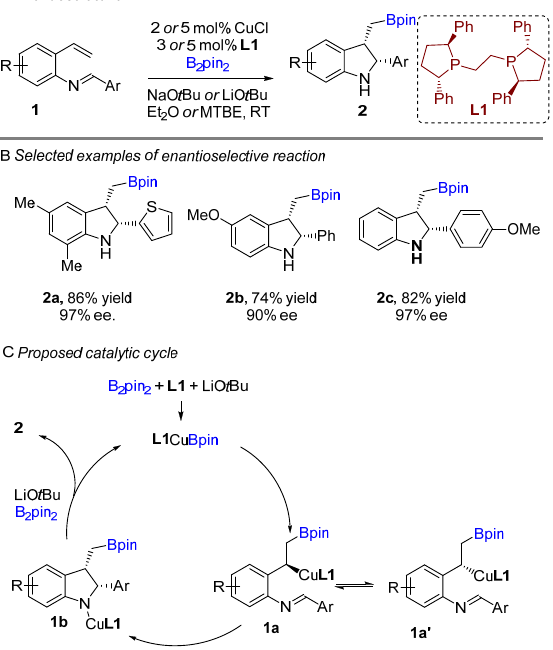
Copper-catalyzed intramolecular borylative cyclization for the synthesis of 2,3- disubstituted